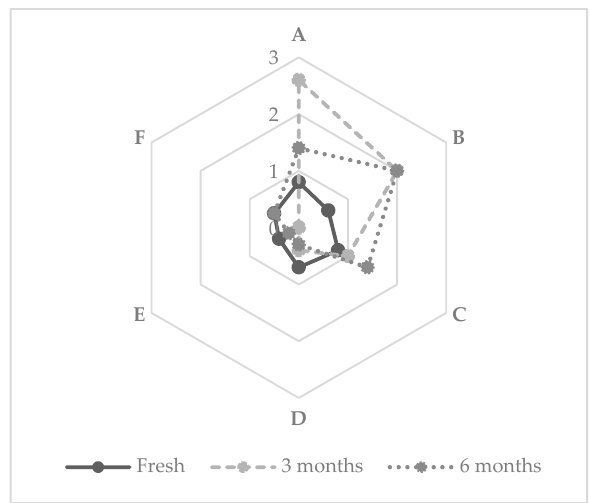
Figure 6. Spider diagram of cardboard flavor intensity in fresh ( ● ), and naturally aged (3 and 6 months) beers (A–F).